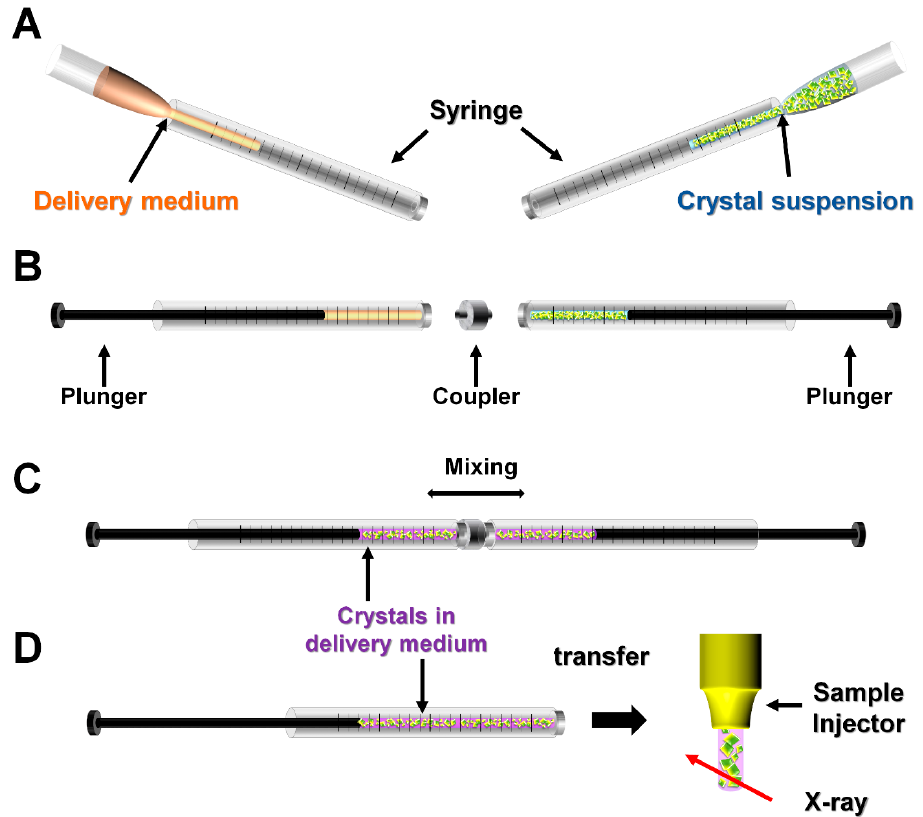
Figure 4. Schematic representation of mechanical mixing of crystals and delivery medium. ( A ) Delivery medium and crystal suspension are injected into separate syringes. ( B ) The syringes containing the delivery medium and the crystal suspension are connected using a coupler. ( C ) The crystal and delivery medium are gently mixed. ( D ) The delivery medium containing the crystals is transferred into a sample injector to perform the SX